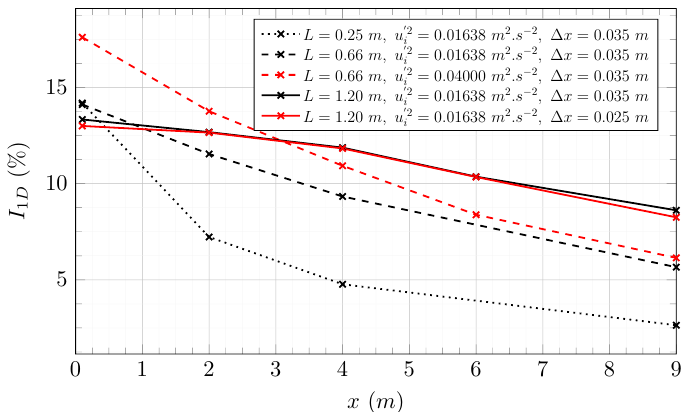
Figure 13. Turbulence rate I 1 D at the centre of the LBM domain for different parameters of the DFSEM. The targeted turbulence rate is 12.5%. x is the distance from the inlet of the LBM domain. In cases where L is equal to 0.25 m and 0.6 m both, have a strong decay of the turbulence rate. The eddy size seems to have a great influence on the decay of the turbulence rate. Cases (cid:48) 2 = 0.01638 m 2 .s − 2 and u (cid:48) 2 = 0.04000 m 2 .s − 2 converge toward the same with u i i